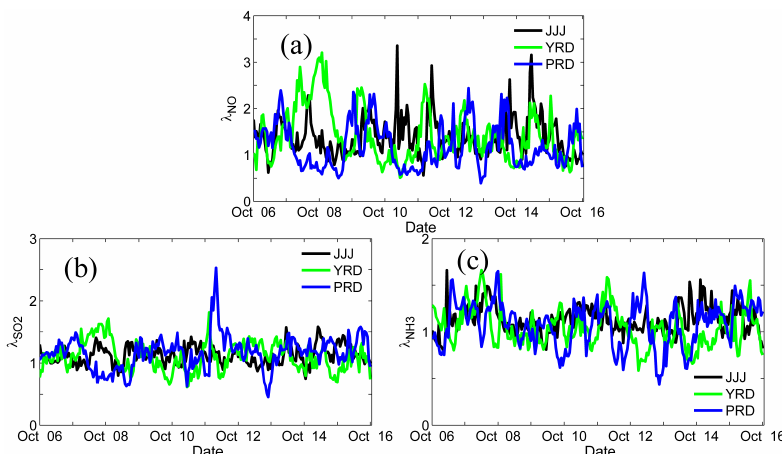
Figure 6. Hourly area-averaged time series of emission scaling factors extracted from the ensemble mean of the analysed (a) λ a and (c) λ a over the three sub-regions: Beijing–Tianjin–Hebei region (JJJ, black), Yangtze River delta (YRD, green) and Pearl River delta NH 3 (PRD, blue).